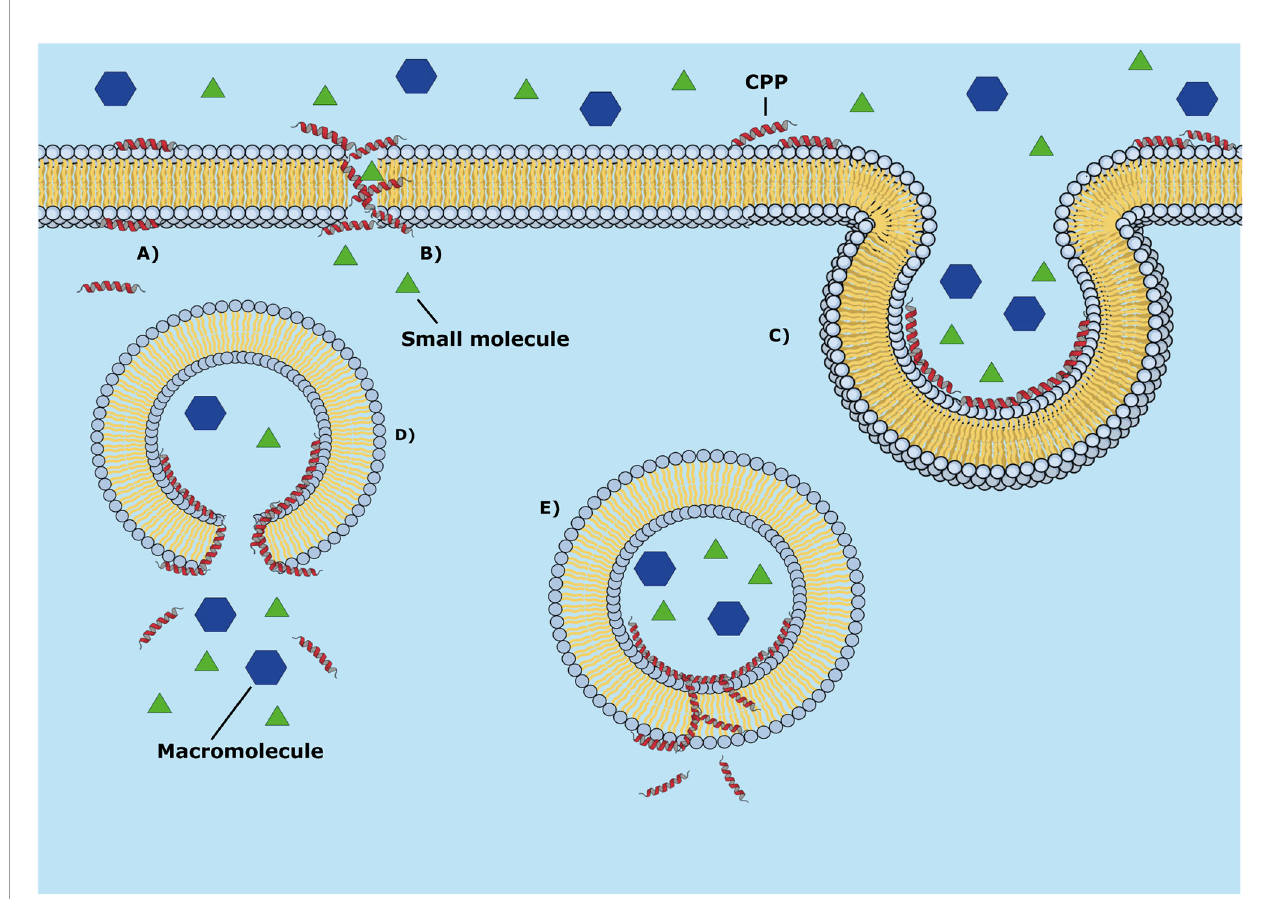
FIGURE 6 | Mechanisms of passive penetration of CPPs into the cell membrane (energy-independent mechanisms). (A) Passive diffusion (spontaneous translocation), (B) Peptide aggregation with pore formation, (C) endocytosis. The panels (D) and (E) represent some subsequent molecular events in the cell: (D) endosomal membrane lysis and (E) translocation through the cell